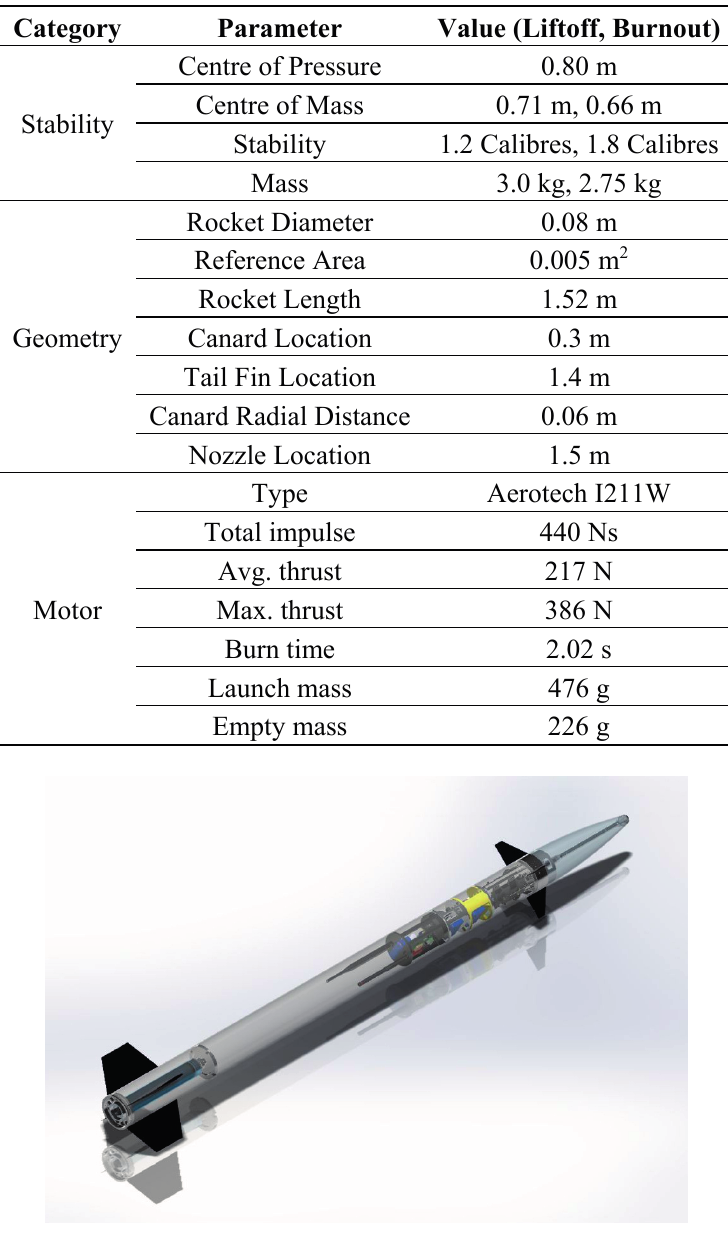
Figure 3. Smokey rocket